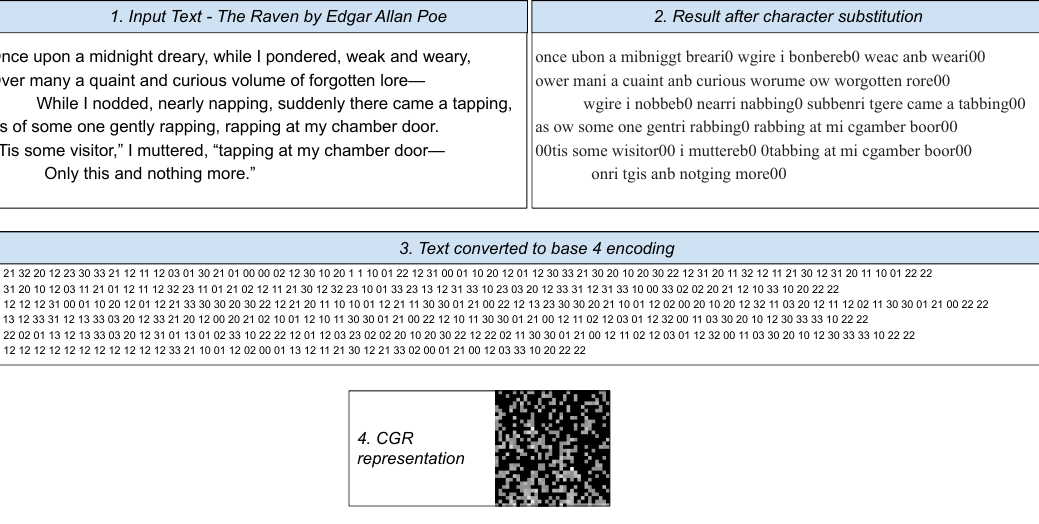
Figure 2. Example of the transformation of a small text to chaos game representation (CGR).